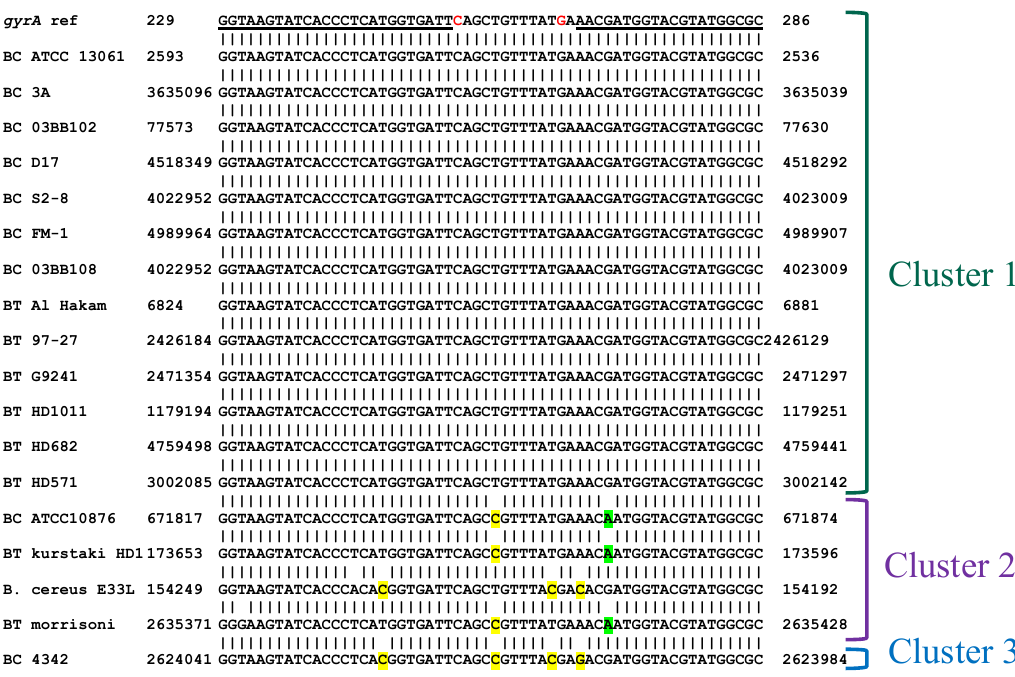
Figure 10. HRMA— B. cereus and B. thuringiensis gyrA . ( a ) Melt curves for B. cereus and B. thuringiensis gyrA amplicons. ( b ) Comparison of reference gyrA sequence with published sequences for the B. cereus (BC) and B. thuringiensis (BT) strains (see Table 13). Primer sequences are underlined; nucleotide substitutions at the locations shown in red have been documented to cause resistance. Substitutions predicted to increase or decrease amplicon T m s are highlighted in green or yellow, respectively.